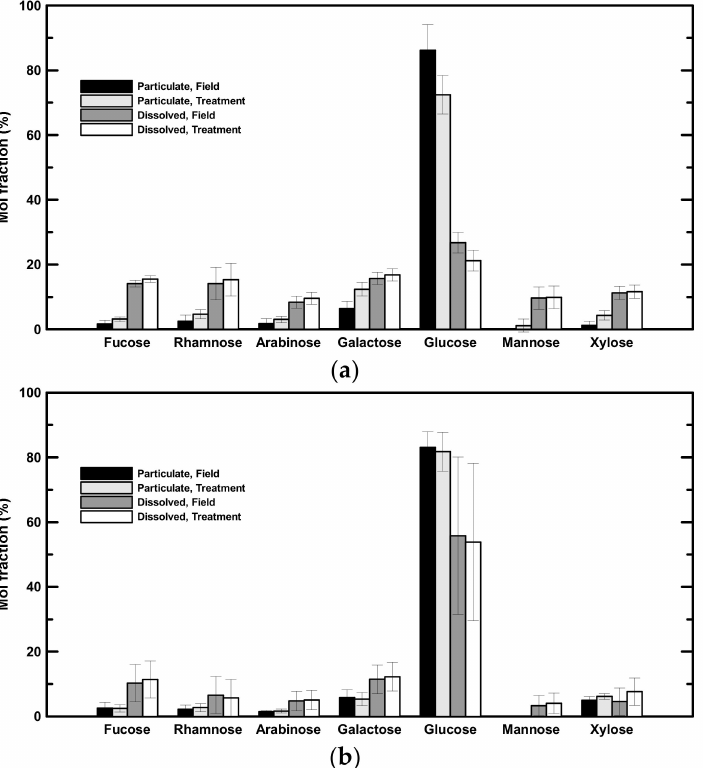
Figure 3. Mol fractions of individual neutral aldoses. ( a ) Averaged mol fractions of neutral aldoses in low-salinity samples. ( b ) Averaged mol fractions of neutral aldoses in high-salinity samples. The concentrations of individual amino acids were determined (Table 4).